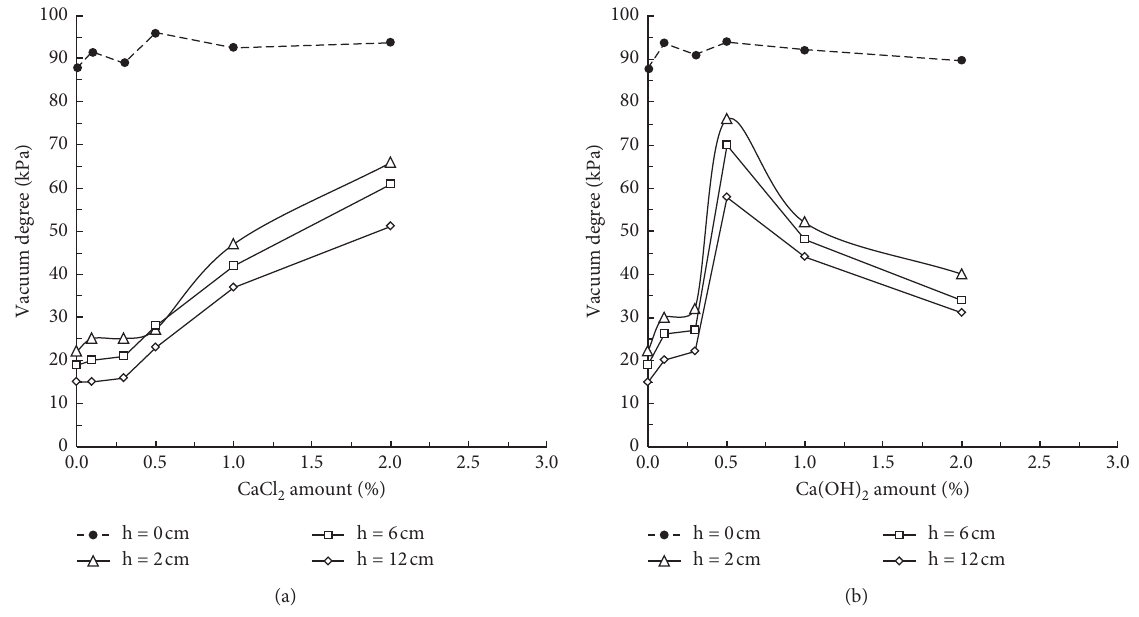
Figure 7: Variation of stable vacuum degree with flocculants’ amount.